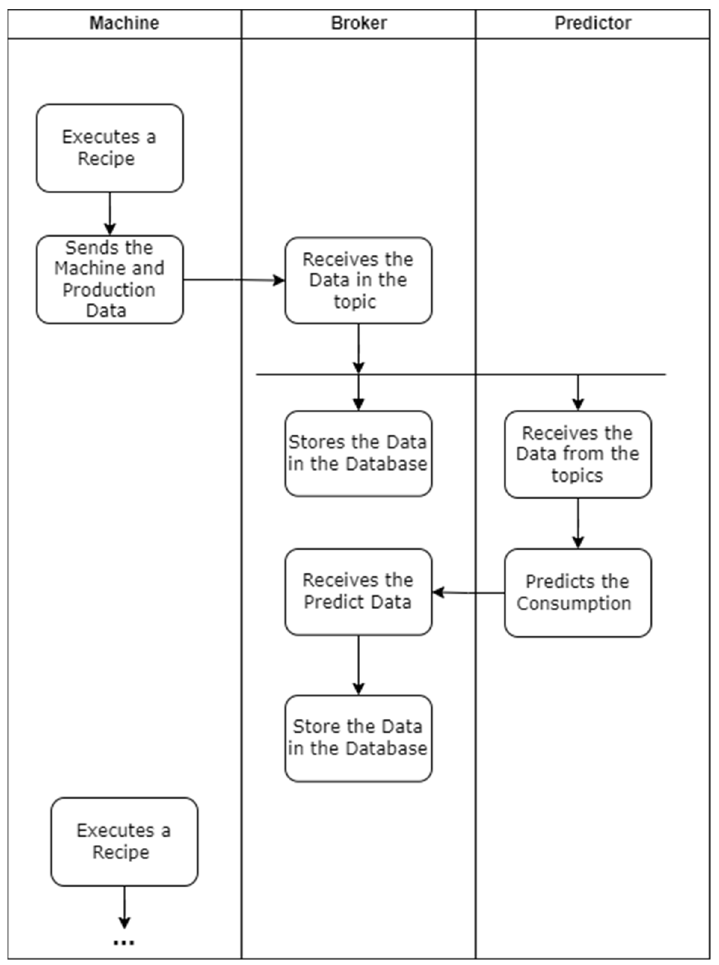
Figure 2. Activity diagram of the architecture.